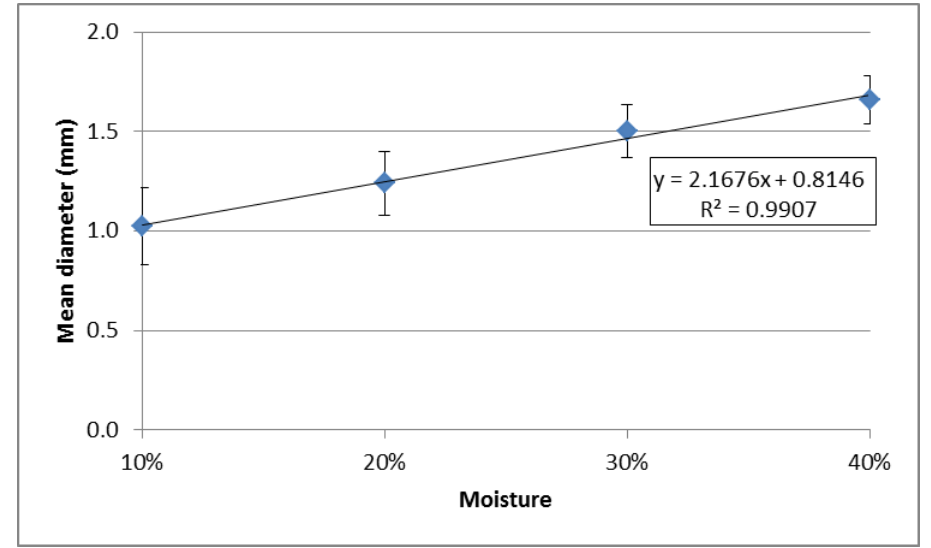
Figure 2. Correlation graph of moisture content (%) for milling with mean grain diameter.